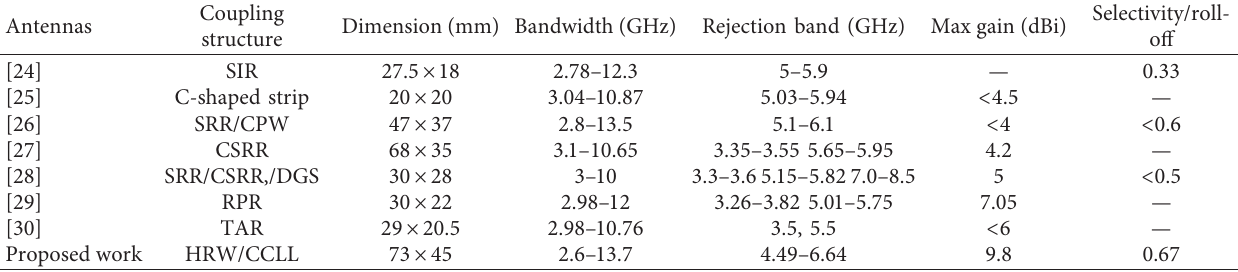
Table 1: Comparison of the proposed antenna with other reported